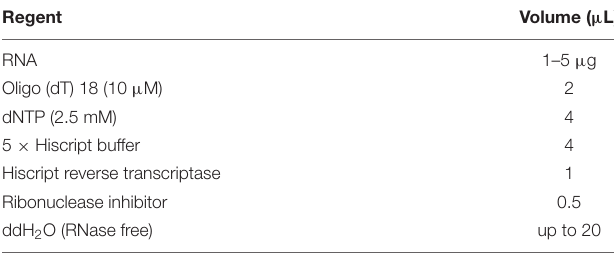
TABLE 1 | Reverse transcription reaction.